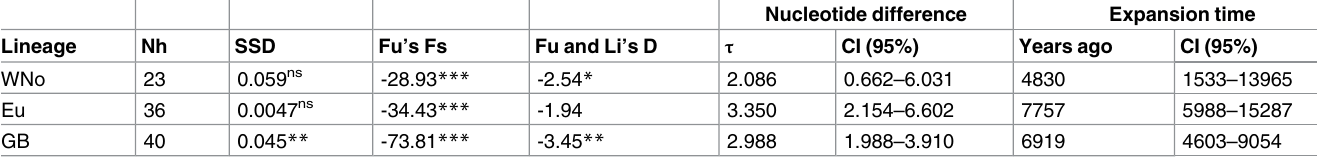
Table 2. Population genetic statistics for Ixodes ricinus mtDNA lineages.